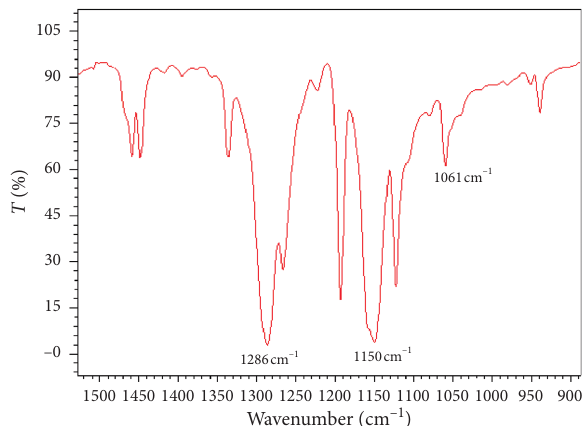
Figure 2: Solid-state FT-IR spectrum of the residual solid resulting from the benzothiophene oxidation.